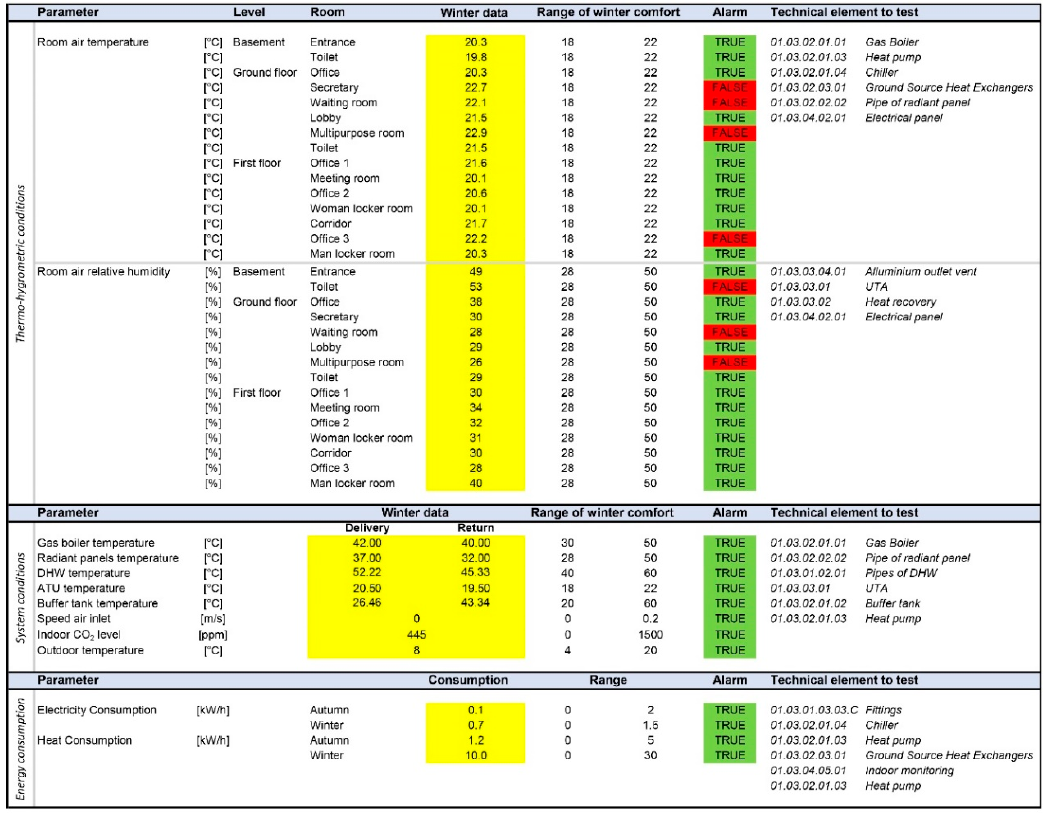
Figure 14. Monitoring data sheet for the building control.